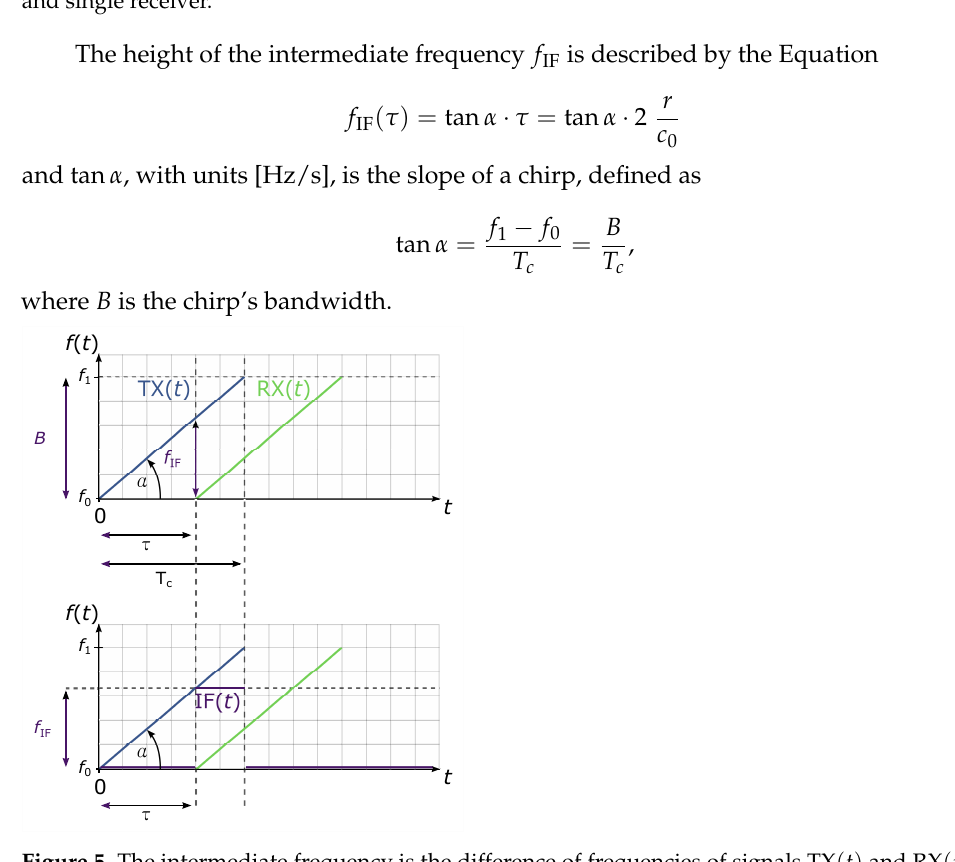
Figure 5. The intermediate frequency is the difference of frequencies of signals TX ( t ) and RX ( t ) . T c marks the duration of a chirp, f 0 is the starting frequency and f 1 is the stop